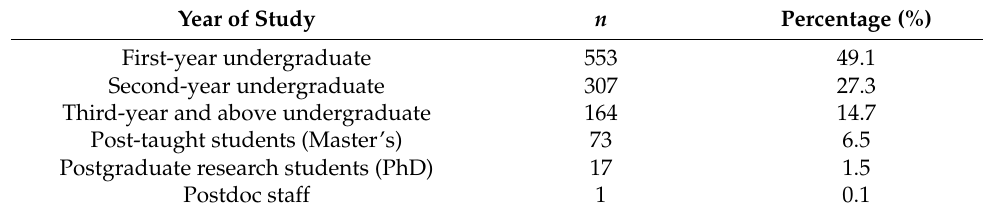
Table 3. Breakdown of the year of studies ( N =